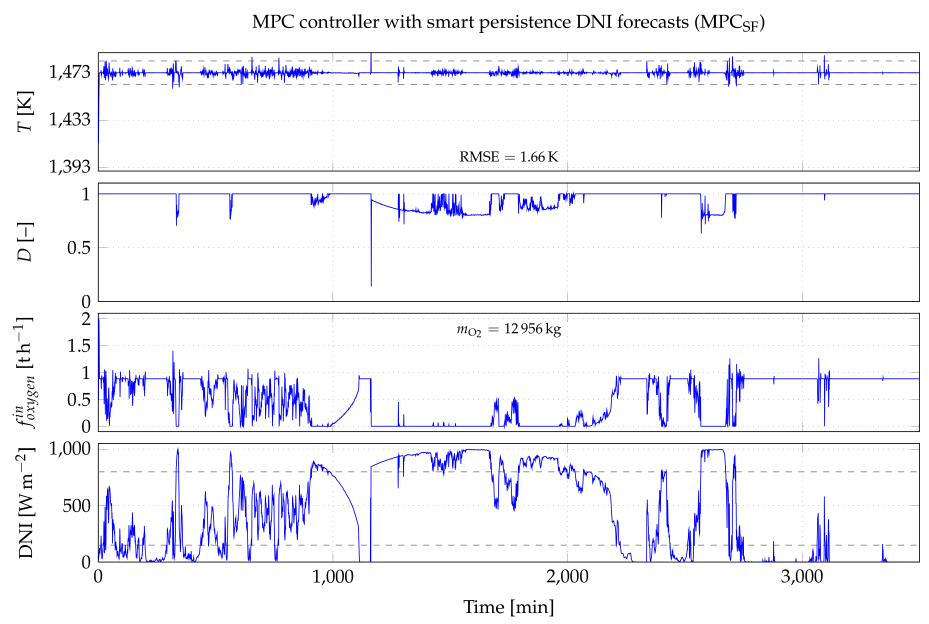
Figure 17. Case study results: MPC controller with smart persistence DNI forecasts (MPC SF ). The pre- diction horizon of the controller is 1.5min.